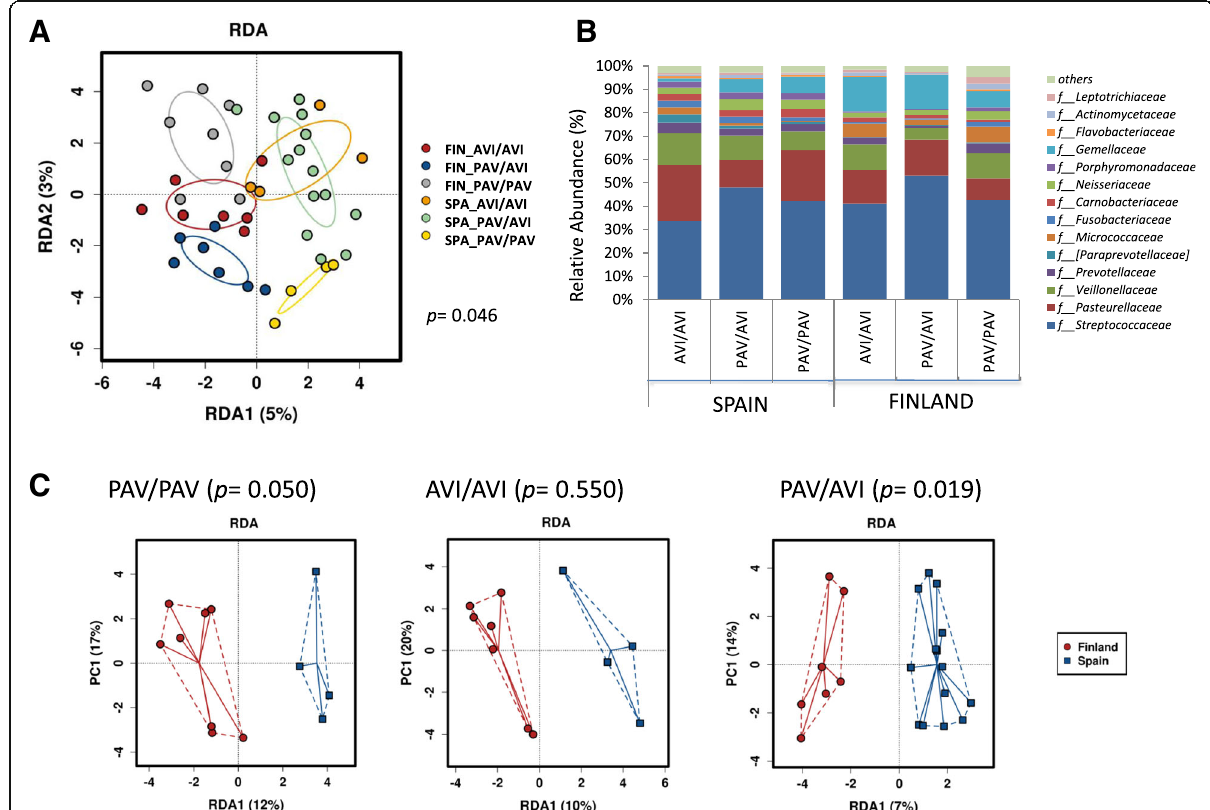
Fig. 2 Association between taste genotype, country, and oral microbiome. a RDA plots based microbiota analysis at OTU level depending on country and taste genotype (1:AVI/AVI, 2:PAV/AVI, and 3:PAV/PAV). b Relative abundances (%) in each specific TAS2R38 taste receptor genotype and country. c RDA plots at OTU level on each genotype for country effect. Ellipses represent 95% confidence intervals from centroids of the interaction between